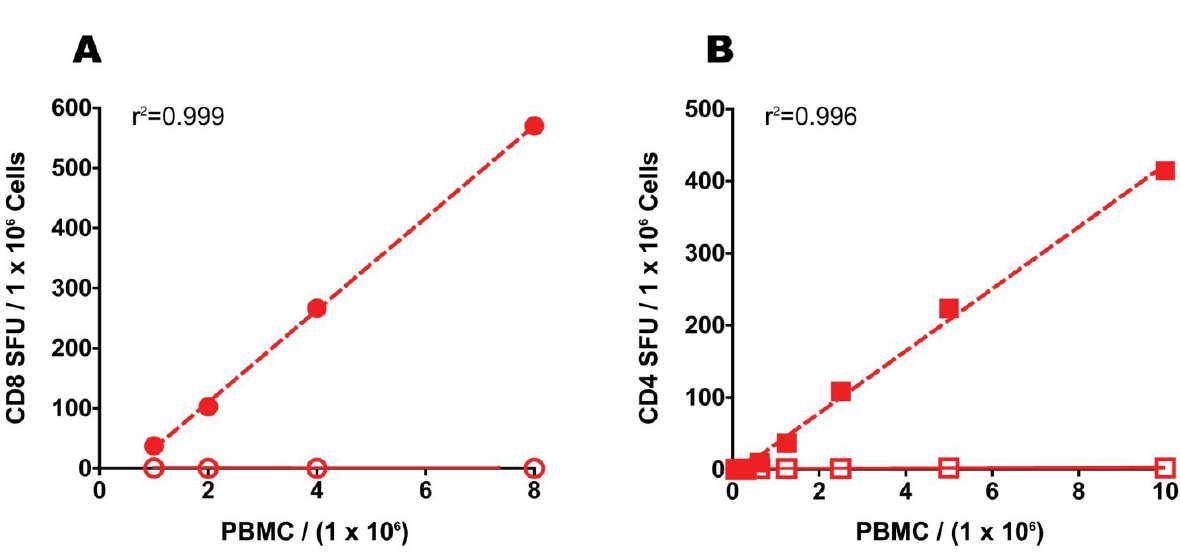
Figure 7. Relationship between the numbers of freshly thawed PBMC added per well and observed SFU in ELISPOT. CEF peptide ( A ) or mumps antigen-elicited SFU ( B ) plotted against the number of PBMC added per well. The PBMC were plated in serial dilution with antigen (closed symbols) or without (medium alone, open symbols) keeping all other assay variables constant. The regression for antigen-induced SFU was calculated and is shown. The data are from one